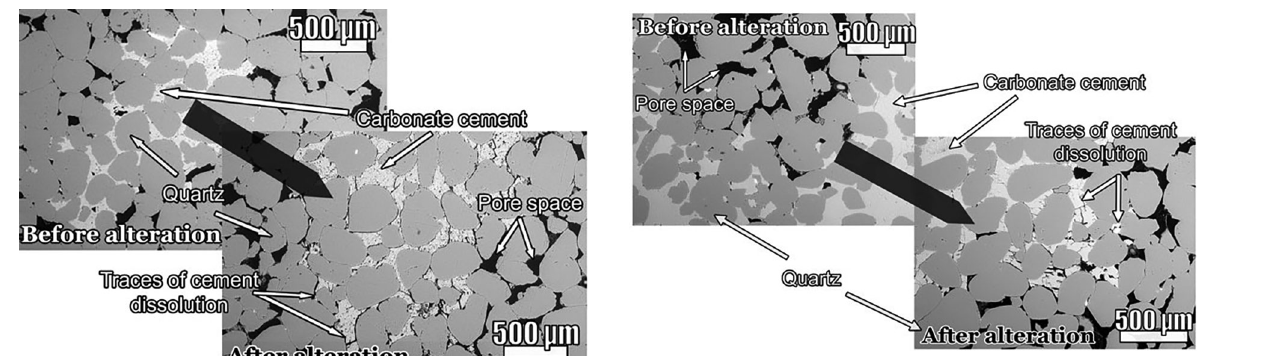
Fig. 6. SEM microphotographs of thin sections of reservoir carbonate-cemented medium- to fine-grained well-sorted Deimena Formation sandstone sample E7-3 (Table 3) before (left) and after (right) the alteration experiment. The sandstone composition is oligomictic, characterized by predominantly subrounded quartz grains. The sample is characterized by tight compaction of grains. Interparticle porosity is connected by very thin intermediate channels responsible for low permeability before alteration (Table 5). Visual analysis of thin sections (left and right) confirmed the measured results (10–15% by Shvetsov 1948, Table 5). The light-coloured area is carbonate cement (calcite, ankerite and dolomite), locally making more than 50% of the rock pore volume. Traces of the dissolution and microfracturing of carbonate cement on the edges of grains and inside the pore filling and the displacement of clay cement blocking pores were determined after the experiment (right). Increase in microporosity is responsible for increase in permeability measured after alteration (Table 5). Sample E7-3 is of ‘cautionary-2’ reservoir quality (class VI) with improved quality up to ‘moderate’ (class IV) after alteration.